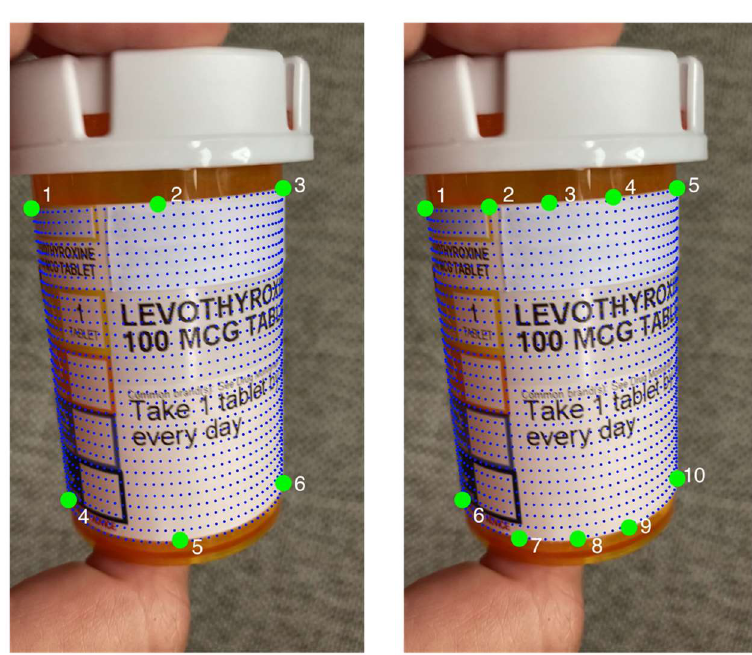
Figure 3. Warp Mesh for six- and ten-point models. In this case, the mesh quality is similar in both cases. However, having more points makes the model more resistant to prediction errors on individual points and allows for the shape to be defined more